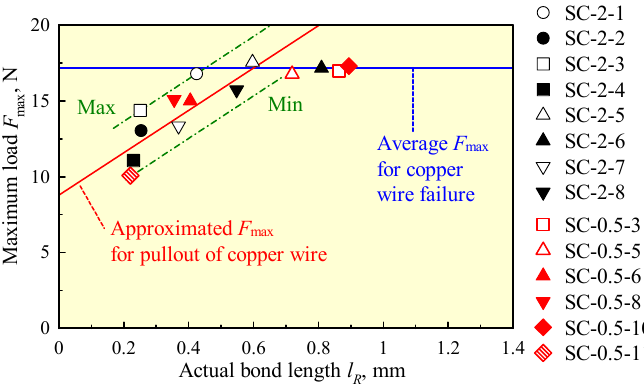
Figure 12. Relationship between the maximum load, F max , and the actual bond length, l R , for specimens failed by pullout of copper wire.